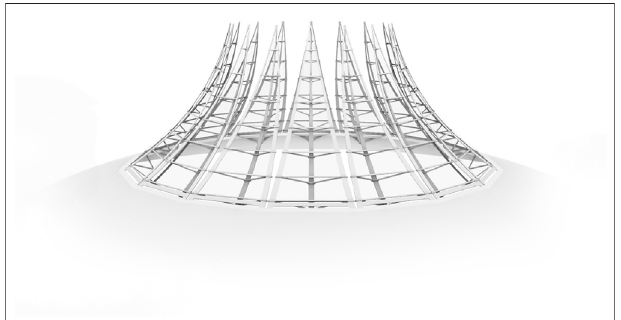
FIGURE 13 | Study of an active hybrid roof structure at the BTU as part of preliminary investigations for prototyping.